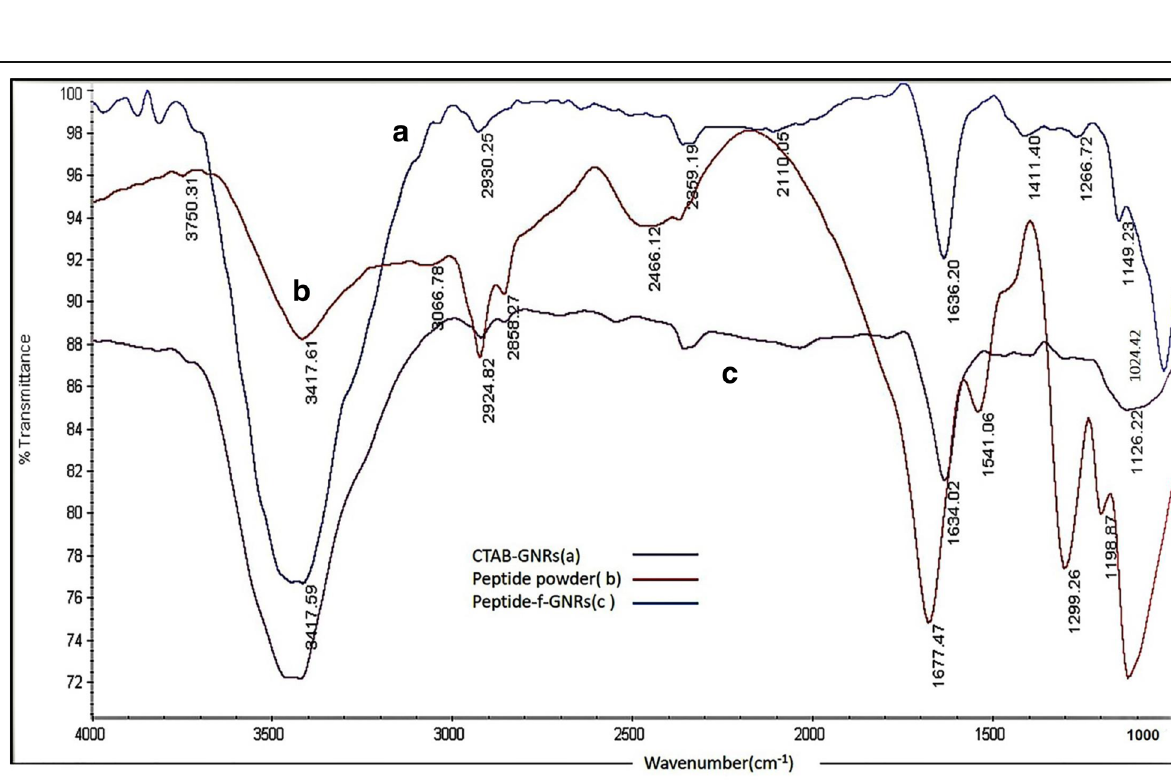
Fig. 4 SERS of peptide on the gold nanorods and Raman spectrum of peptide powder and CTAB-GNRs at 250 – 3600cm − 1 region ( a ) and 100 – 500 cm − 1 region ( b